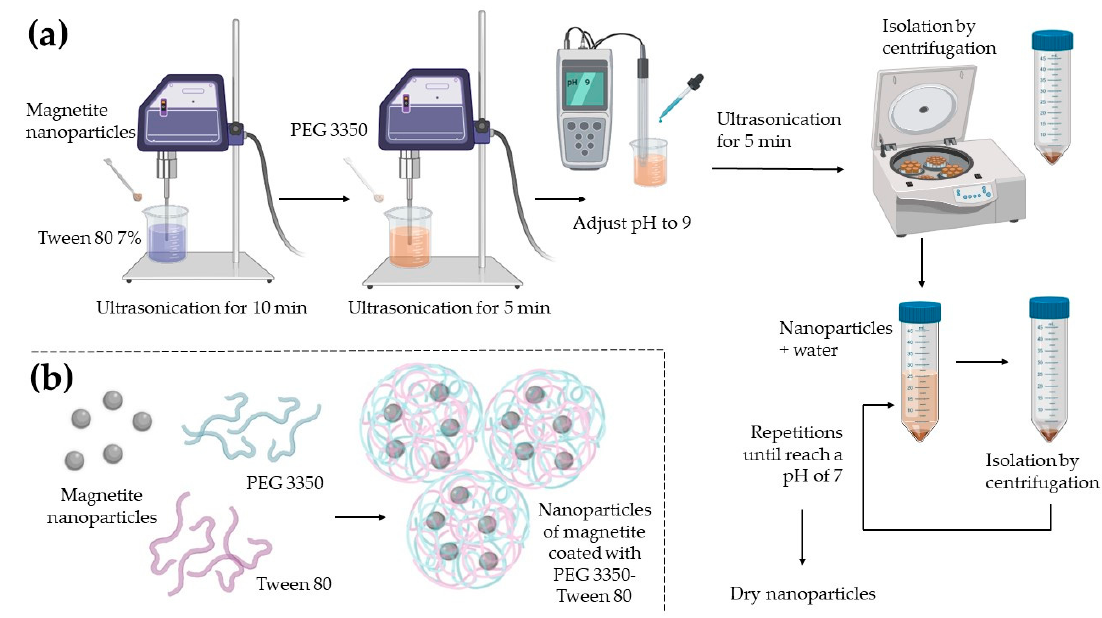
Figure 1. A scheme cartoon of the coating process of nanoparticles with PEG 3350 and Tween 80 . ( a ) A complete diagram of the coating process methodology. ( b ) The interaction of PEG 3350 and Tween 80 with the magnetite nanoparticles is possible because of physical forces, creating a polymer network around the magnetite nanoparticles.